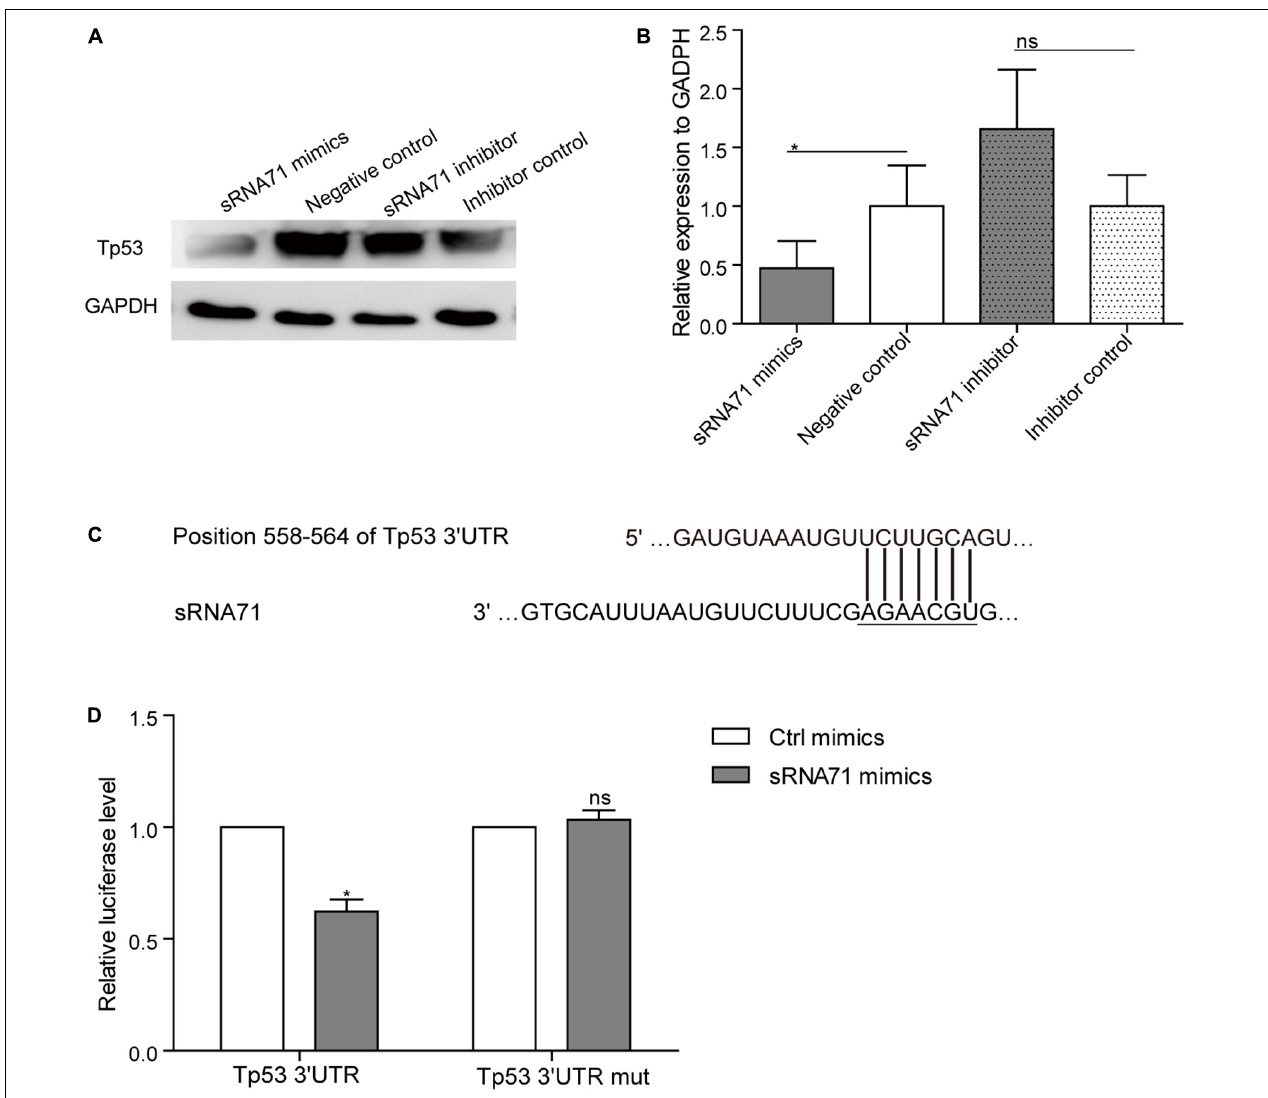
FIGURE 4 | sRNA71 inhibited the expression of Tp53. (A,B) Western blot analysis of the expression of Tp53 in HEK293T cells transfected with sRNA71 mimics, negative control, sRNA71 inhibitor, or inhibitor control, respectively. Images are representative results of three independent experiments. (B) The protein abundance of Tp53 was quantified with normalization by signals of GAPDH. Means ± SEM from n = 3 independent experiments. (C) Schematic representation of the predicted binding site. (D) HEK293T cells transfected with Tp53 3 (cid:48) UTR firefly luciferase reporter vector (Wild-type vector or mutant vector), renilla luciferase vector, and sRNA71 mimics were compared to those transfected with negative control for the same period of time. After 48 h, cells were lysed and monitored for luciferase activity. The relative luciferase level was normalized by the reference “Renilla.” Means ± SEM from n = 3 independent luciferase reporter assays, * P < 0.05 vs. negative control, “ns” reflects no statistically significant